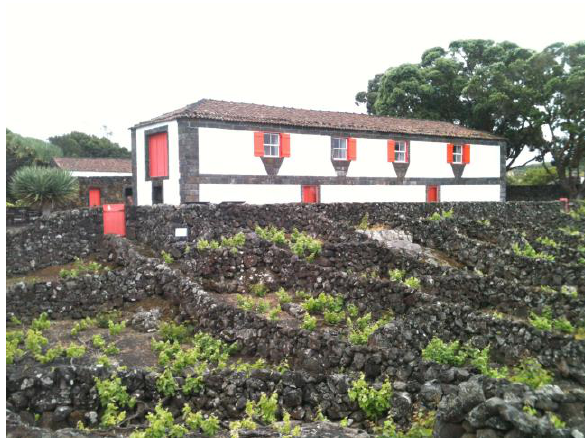
Figure 6. The Wine Museum by the local architect Paulo Gouveia (1939-2009). Photo by Rui